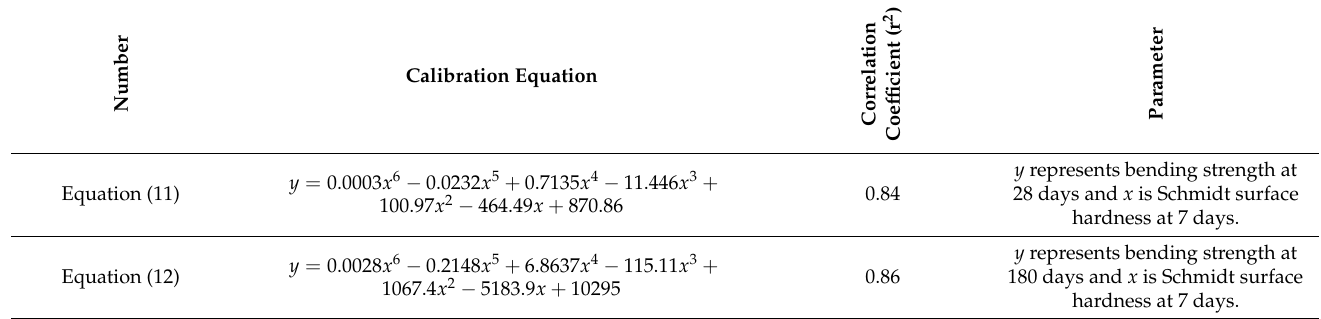
Table 8. Calibration equations for predicting bending strength from Schmidt surface hardness.